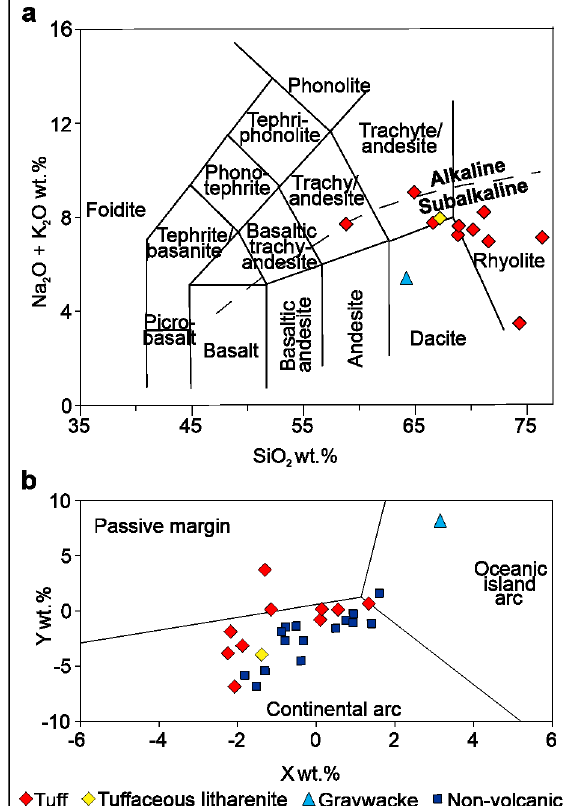
Figure 6. Geochemistry plots a) Total alkali vs. silica (TAS) compositional plot (based on Irvine & Baragar 1971, Middlemost 1994). b) Tectonic setting plot, where X = 0.303 − 0.0447SiO2 − 0.972TiO2 + 0.008Al2O3 − 0.267Fe2O3 + 0.208FeO − 3.082MnO + 0.14MgO + 0.195CaO + 0.719Na2O − 0.032K2O + 7.51P2O5 and Y = 43.57 − 0.421SiO2 + 1.988TiO2 − 0.526Al2O3 − 0.551Fe2O3 − 1.61FeO + 2.72MnO + 0.881MgO − 0.907CaO − 0.177Na2O − 1.84K2O + 7.244P2O5 (based on Bhatia